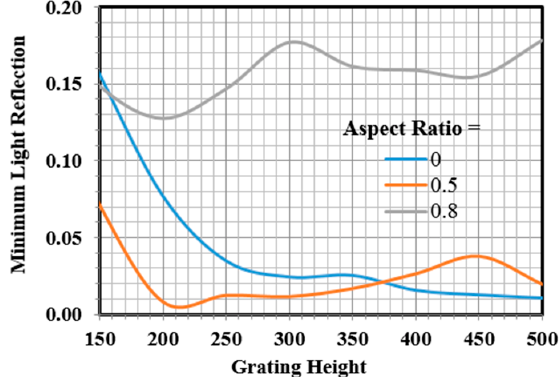
Figure 9. Minimum light reflection versus the nano ‐ grating height characteristics with the grating period or pitch of 830 nm. Here, the aspect ratio is considered “0” as triangular ‐ shaped nano ‐ grating, “0.5” and “0.8” as the trapezoidal ‐ shaped nano ‐ grating.